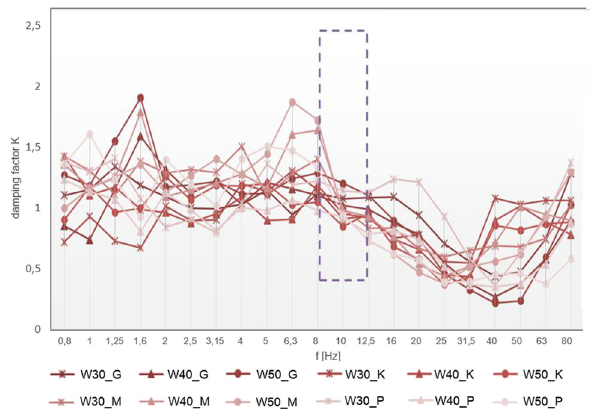
Figure 11: The damping coe ffi cient K ( “ Z ” direction ) when driving on a surface of the hexagonal plate type with a universal wheelchair with the use of polyurethane foam of three thicknesses: markings: W30 – thickness of the pad layer 30 mm, W40 – 40 mm, W50 – 50 mm; G, K, M, P – markings of people.